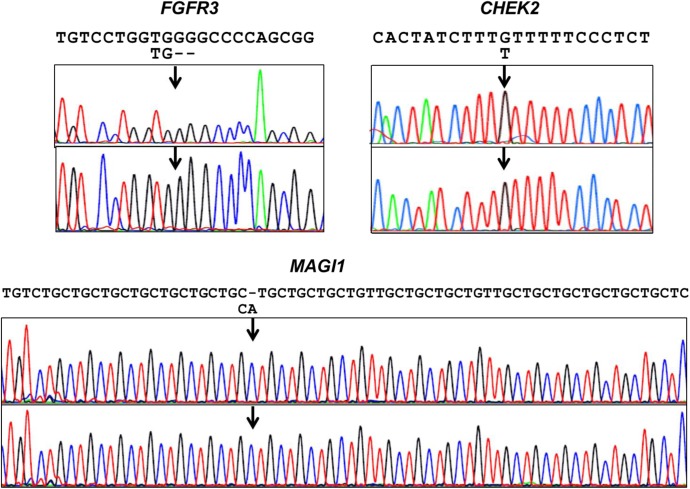
Sanger sequencing of FGFR3, CHEK2, and MAGI1.Variant calls at high frequency were invalidated by Sanger sequencing of amplified products from matched fresh-frozen DNA (upper panel) and FFPE DNA (lower panel). Arrows indicate the positions of a deletion (FGFR3), an SNV (CHEK2) and an insertion (MAGI1), and the variant sequences are shown below the reference sequences.